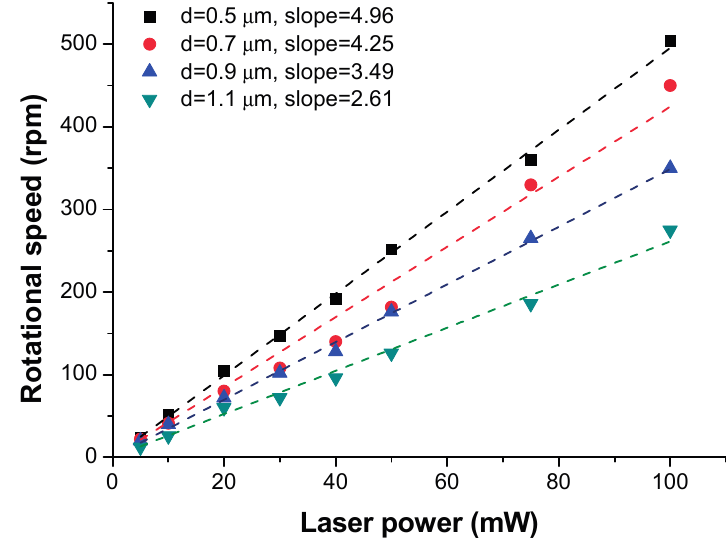
Figure 8. AutoCAD designs of Archimedes screws with central rod.